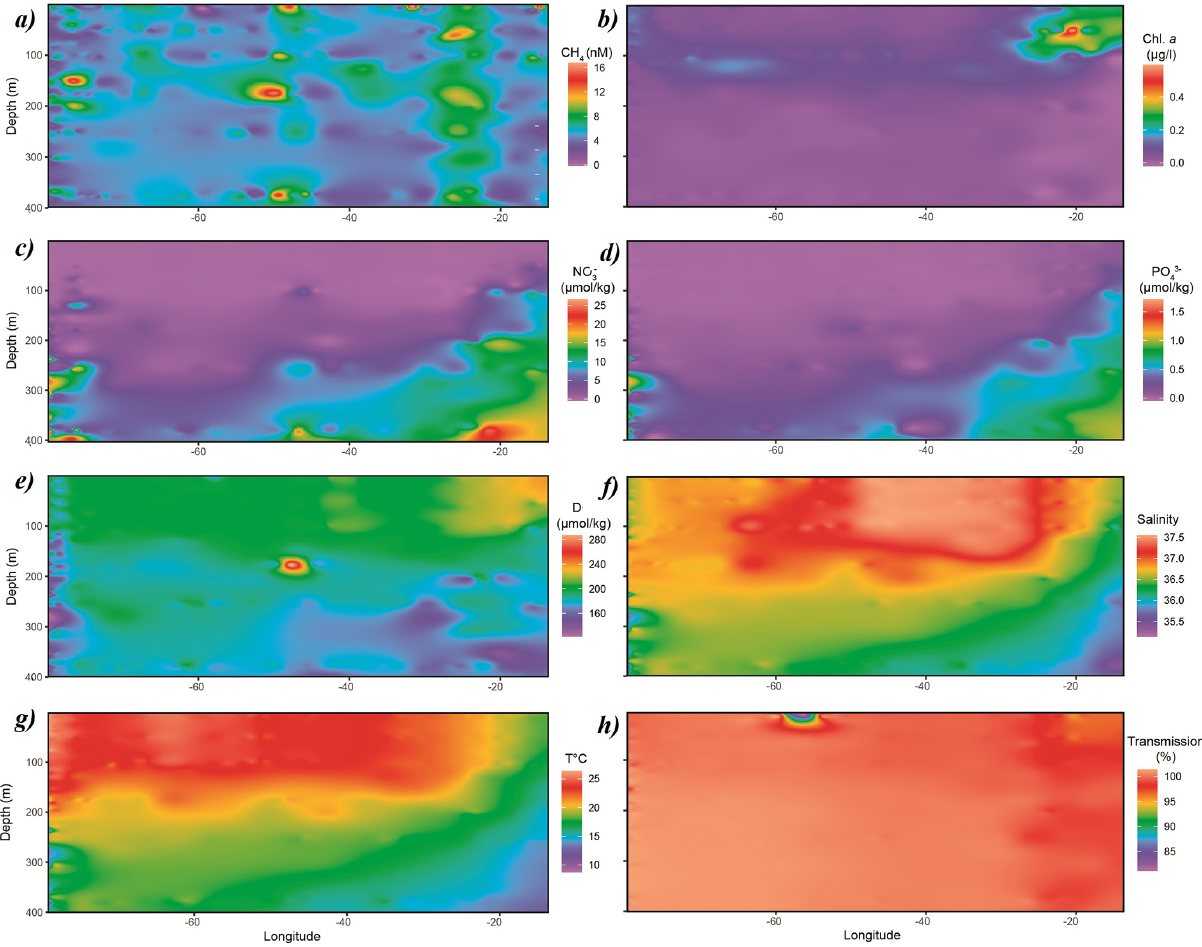
Figure 2. Distribution of (a) CH 4 , (b) Chl a , (c) NO 3 , (d) PO 4 , (e) dissolved oxygen, (f) salinity, (g) temperature and (h) transmission along the cruise track. Chl a , dissolved oxygen, salinity, temperature and transmission data originate from sensors attached to the CTD. CH 4 , NO 3 and PO 4 were measured analytically. Some of the data were taken from CCHDO (Sanchez-Franks, 2020).